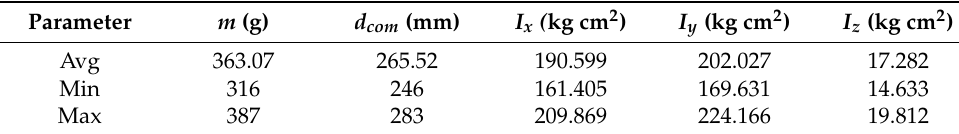
Table 7. Statistic values of the 137 padel rackets.